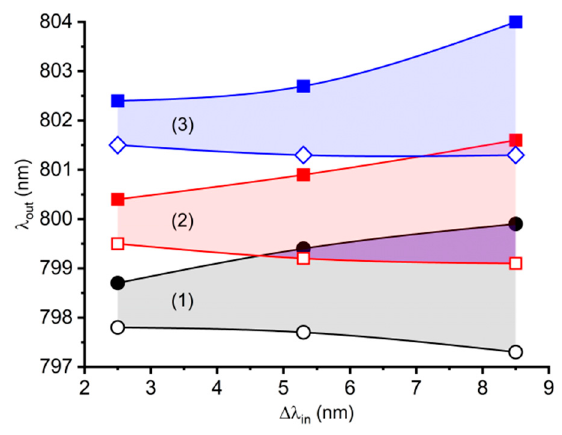
Figure 5. Spectral transfer into vortex beams as a function of input spectral FWHM bandwidth for three wavelength ranges around (1) 798 nm, (2) 800 nm, and (3) 802 nm (spectral profiles in Figure 4a). Filled symbols: upper limits, hollow symbols: lower limits of spectral content in the spectral eyes.